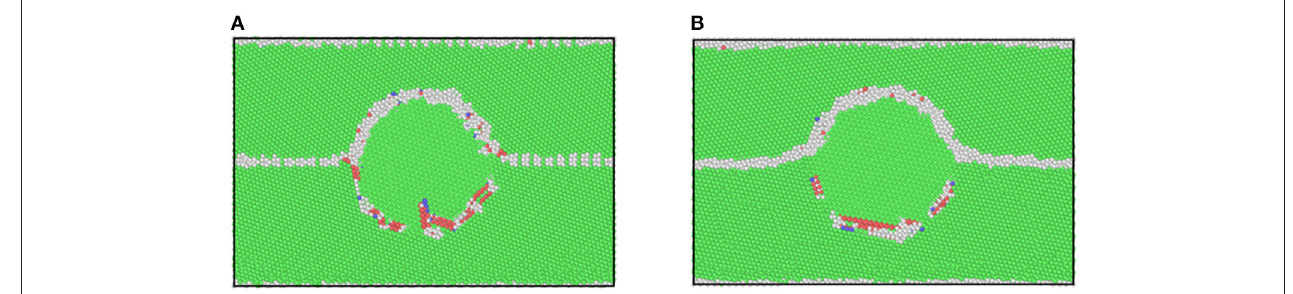
FIGURE 9 | Equilibrium configurations of flat (A) 21.79 ◦ and (B) 38.21 ◦ < 111 > tilt Cu GBs connecting to an 8nm diameter Ag particle. The particle and the lower grain own a cube-on-cube orientation relationship.